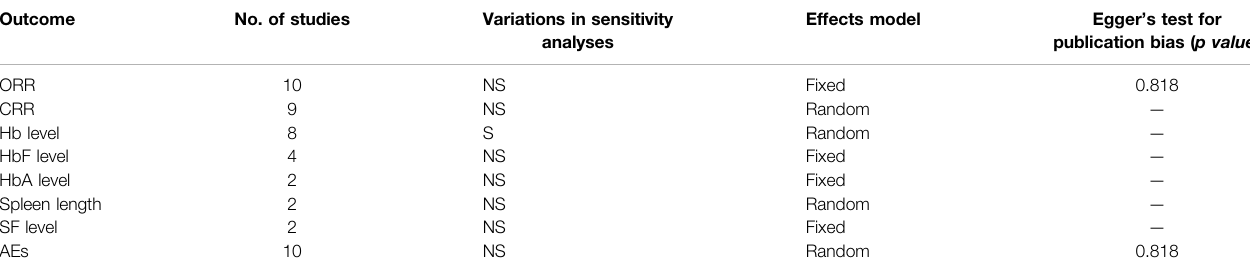
TABLE 2 | Results of sensitive analysis and tests of publication